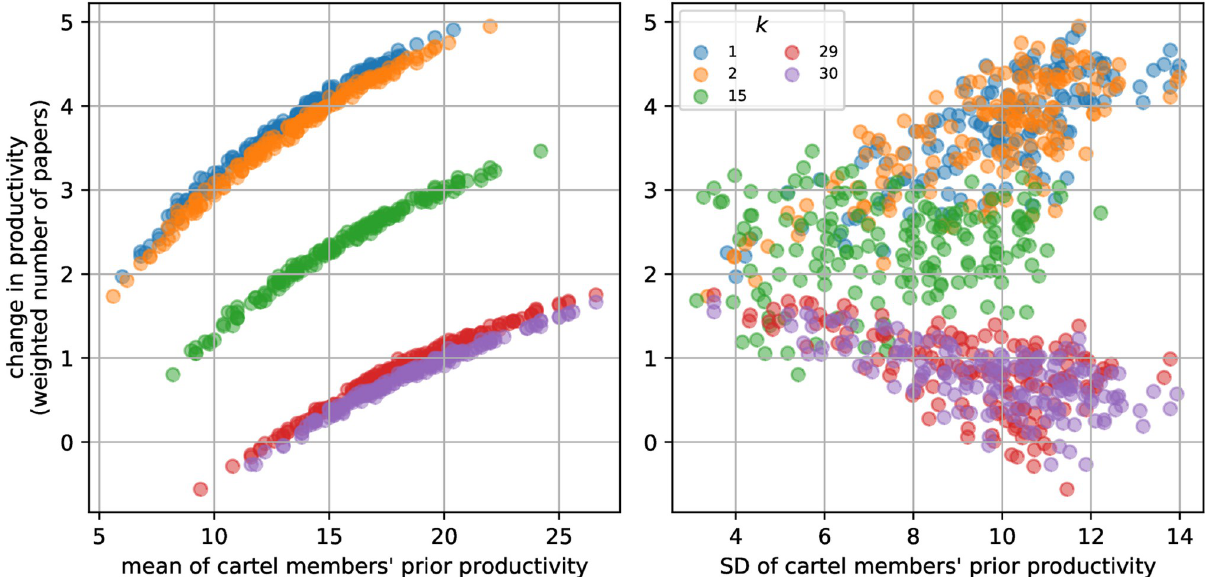
Fig 7. Effect of cartel formation on productivity for differently productive cartel members. The left panel shows the difference in weighted number of papers between simulation with and without cartels for individuals with different prior productivity (see legend on the right panel) as a function of mean prior productiviy of cartel members. Note the negative values (i.e. cartel formation decreases productivity) for highly productive members ( k = 29, 30) at low average cartel productivity. The right panel show the same change as a function of cartel diversity (measured as the standard deviation (SD) of members’ prior productivity). Note, the effect of cartel formation increases with cartel diversity for individuals of low prior production, while decreases for highly productive members (it can be even negative at high cartel diversity). Collaboration graphs were formed with c = 30, k j = j , p = 60, p c = 1 and cartels randomly formed. Each point is the average of 100 simulation for the same cartel. For clarity, only data for authors with extreme low and high and intermediate prior productivity are